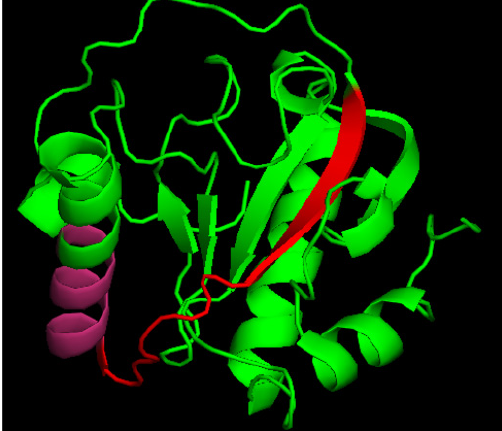
Figure 1. Crystal structure of human PGLYRP1. Red + pink—N3 peptide, pink—p.7 as a part of N3. vitro . Based on these data, we suggested that N3 may reproduce the same ability to induce TREM-1 activation as the whole Tag7 protein. Our first goal was to demonstrate that the N3 peptide can bind to TREM-1. Using affinity chromatography, we found that the N3 peptide (biotin conjugated) binds to sTREM-1. Biotin N3 peptide was detected in elution material after tricine SDS-PAGE followed by streptavidin–HRP Western blotting (Figure 2A). Thus, we have demonstrated that the N3 peptide is able to interact with sTREM-1 in vitro .